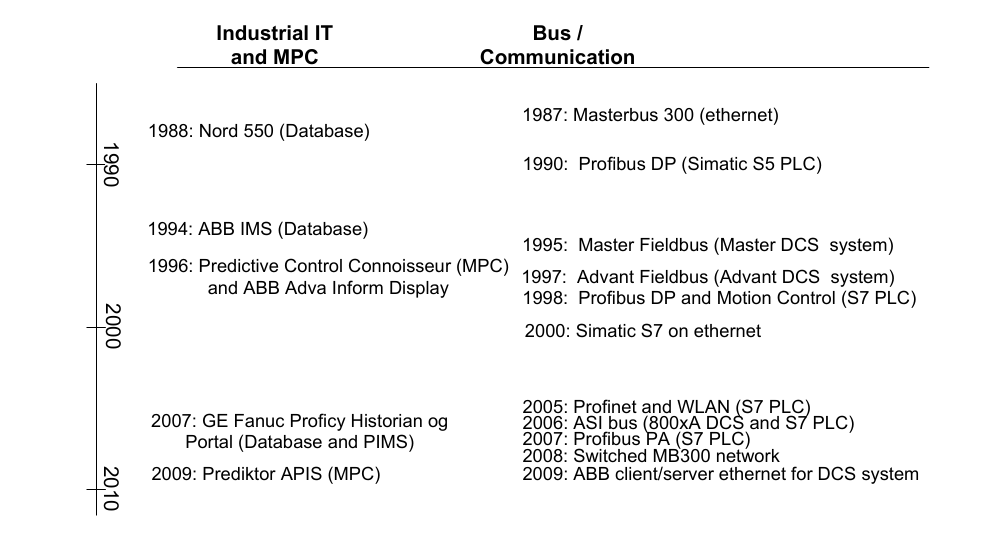
Figure 2: Chronological overview of Industrial IT, MPC and communication systems at Xstrata